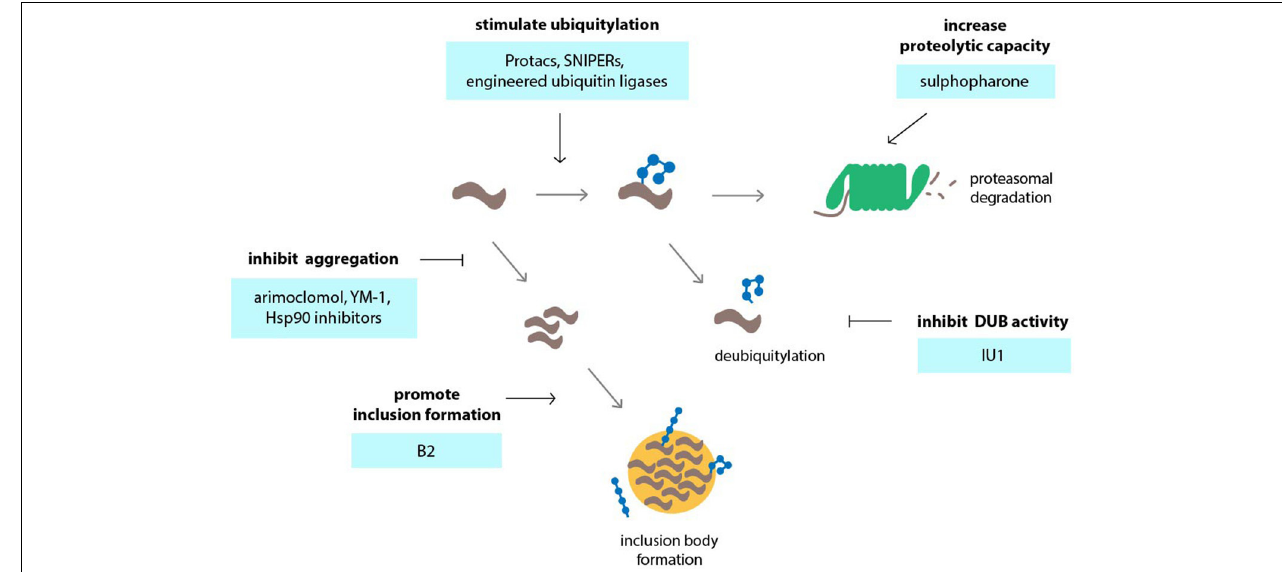
FIGURE 3 | Targeting the ubiquitin-proteasome system (UPS) in neurodegenerative disorders using small molecules or engineering approaches. Various events in the UPS can be targeted by compounds in order to stimulate UPS activity. Among those events are accelerating of ubiquitylation by compounds or engineered